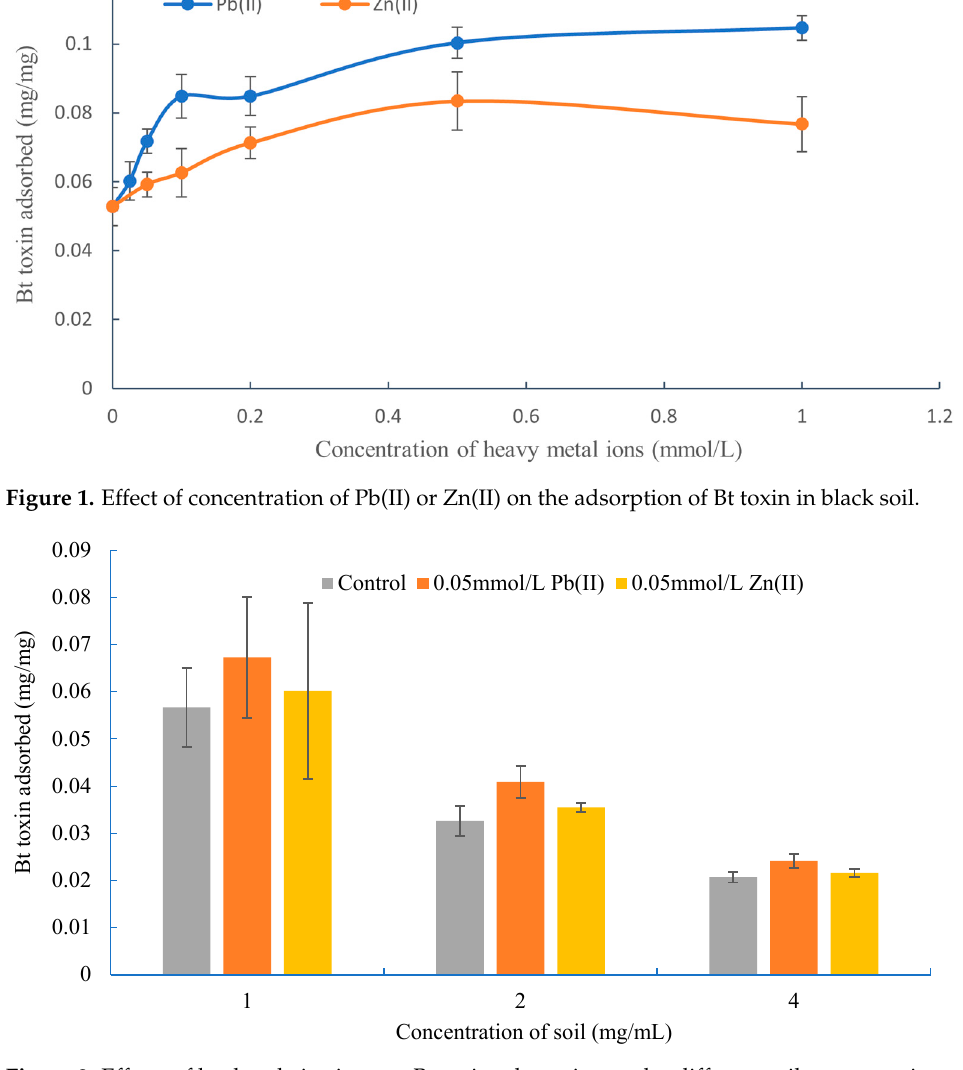
Figure 3. Adsorption of Bt toxin in black soil at different temperatures. As shown in Figure 3, the amount of adsorbed Bt toxin decreased slightly with the increase in temperature from 5 °C to 45 °C without the addition of lead and zinc ions, which agreed with previous results [38]. However, the influence trend of temperature on the adsorption of Bt toxin changed when lead or zinc ions were added to the adsorption system. For the zinc-contaminated black soil (Zn(II) was 0.05 mmol/L in the adsorption system), the adsorption of Bt toxin increased with the increase in temperature, but for the lead-contaminated black soil (Pb(II) was 0.05 mmol/L in the adsorption system), the ad- sorption of Bt toxin increased first and then decreased. One of the reasons for the above